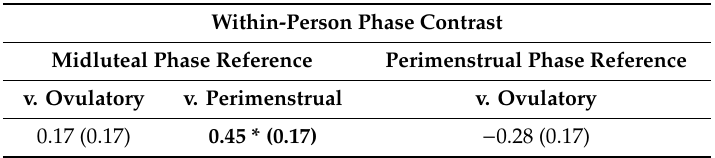
Table 5. Multilevel Regression Models Predicting Log High Frequency Heart Rate Variability (HFlog) from Menstrual Cycle Phase (Within-Person Contrasts) in Study Two ( N = 112 visits).